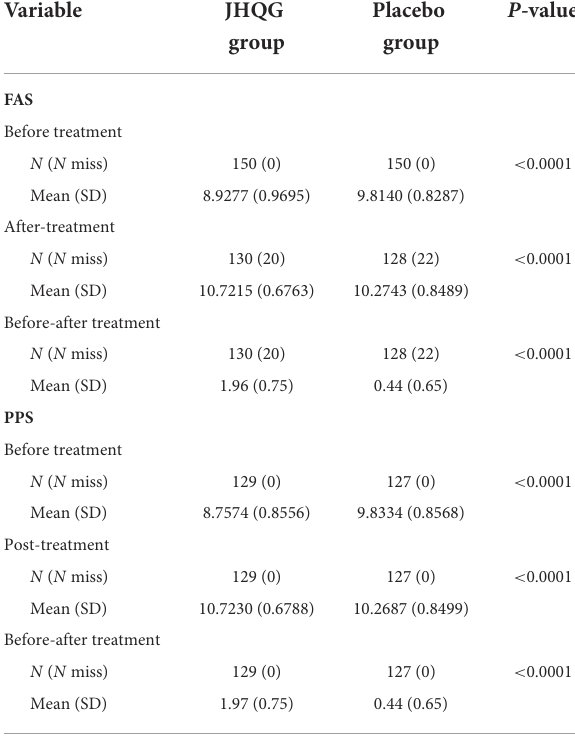
TABLE 6 Change in quality of life (QoL) questionnaire (FAS/PPS). Variable